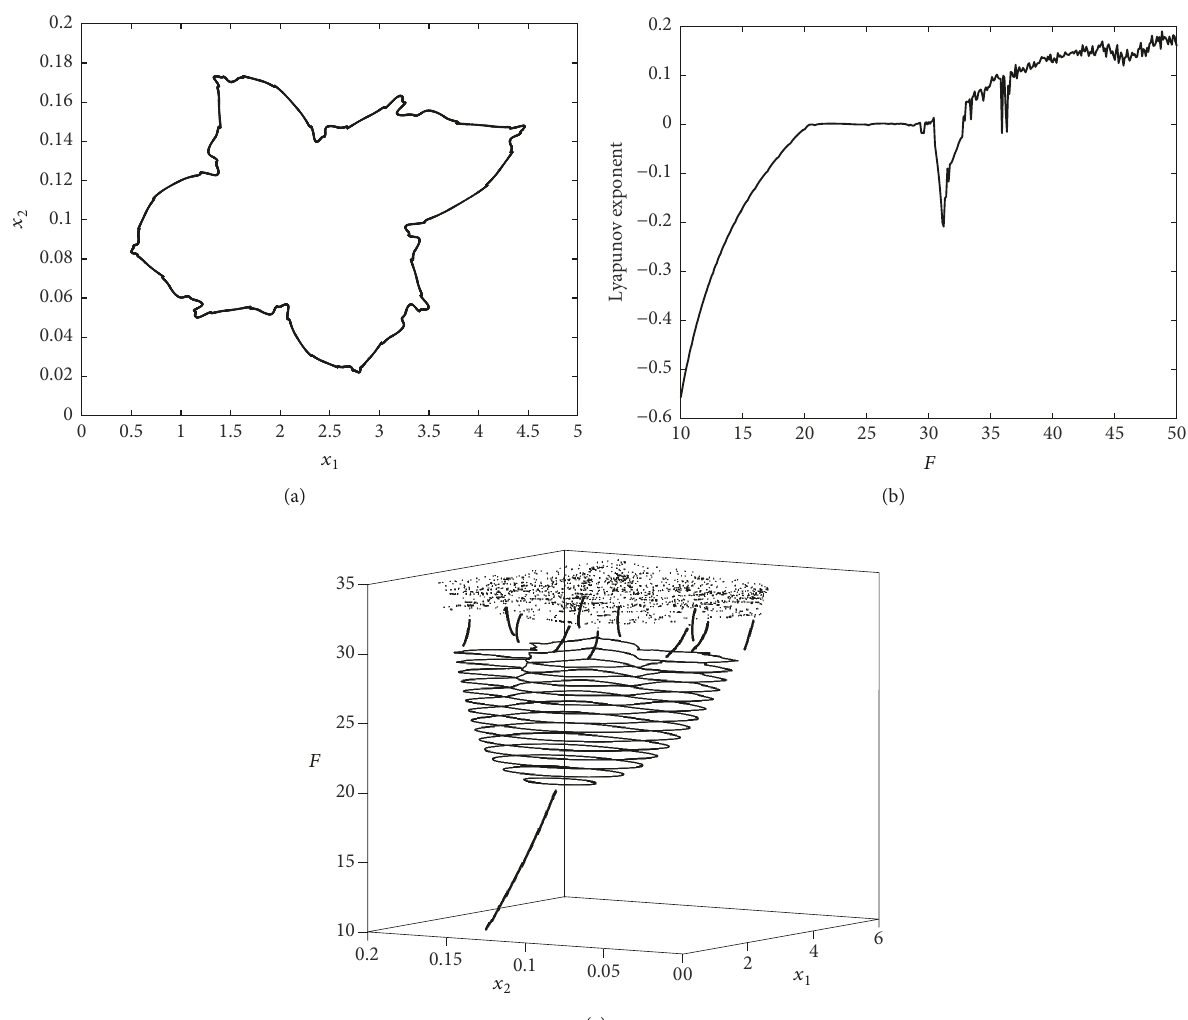
Figure 5: (a) The invariant curve has become kinked. (𝛼,𝛽) = (0.1, 1.0) , (𝑃, 𝐹) = (0.5, 30) . (b) Values of Lyapunov exponents for 𝐹 -values in the interval [10, 50] ( 𝑃 = 0.5 ). (c) Dynamics for selected values of 𝐹 between 10 and 35 . Stable fixed points, invariant curves, kinked curves, periodic dynamics, and chaos,